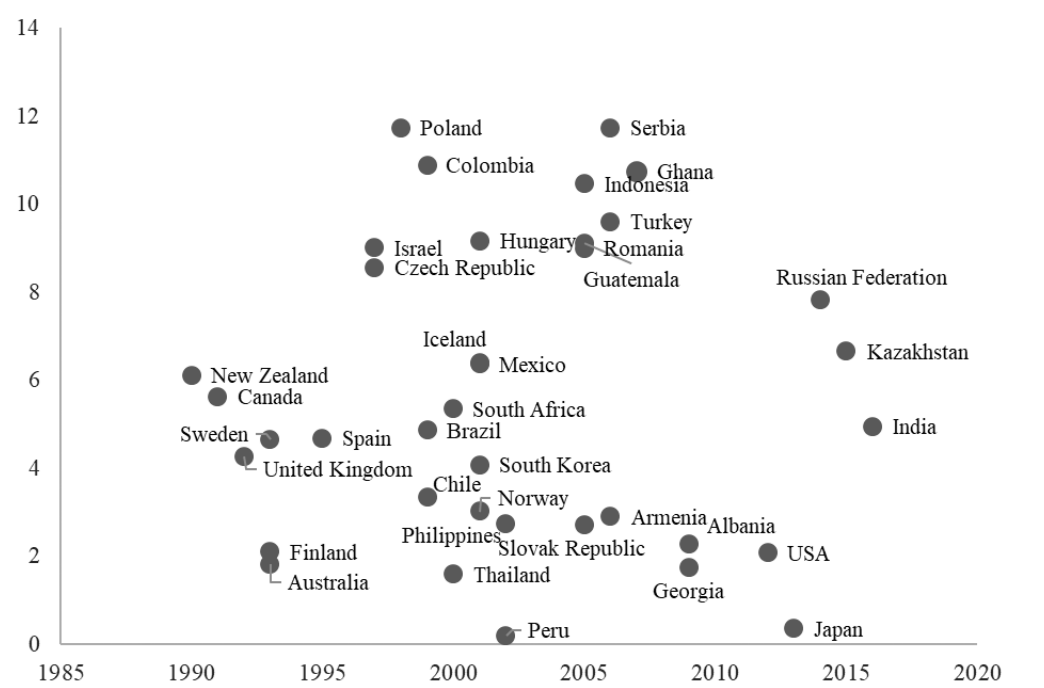
Figure 1. Consumer inflation rate at the date of IT adoption, %